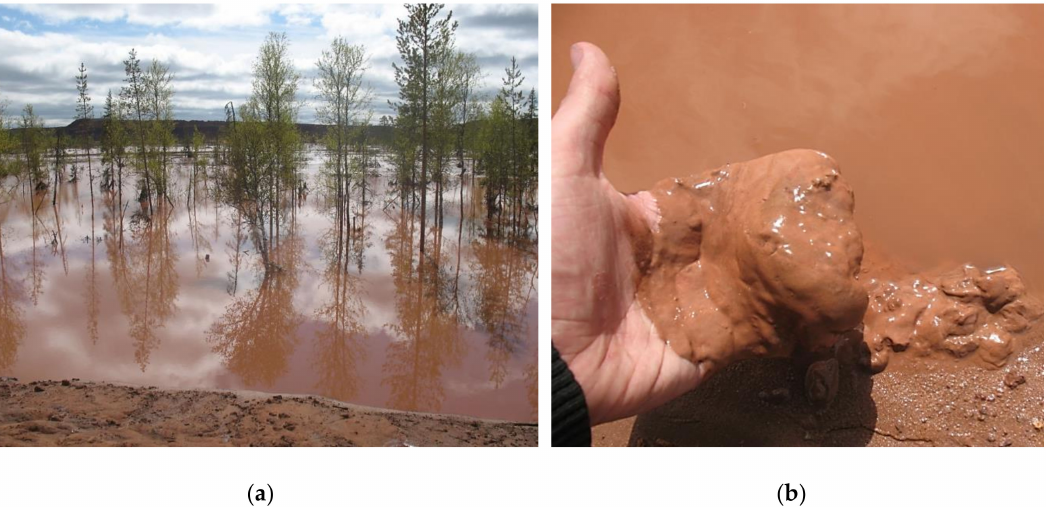
Figure 2. Kimberlite processing waste: ( a ) the settling pond and solids of the beachside terrain; ( b ) close-up view of the characteristic slurry with the predominant (85%) particle size class of < 25 µ m [54].